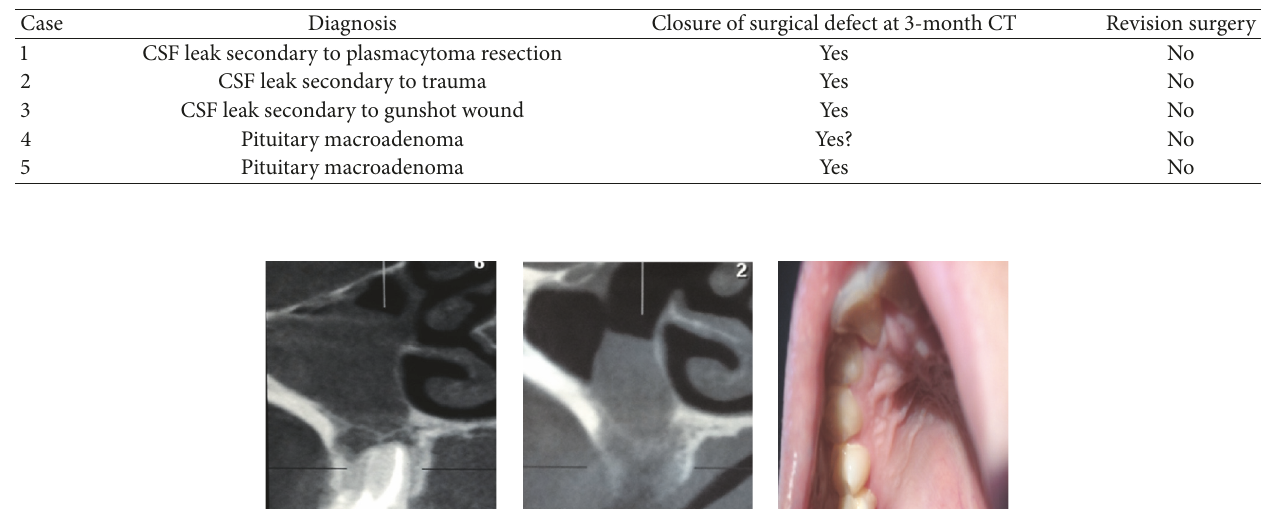
Table 1: Patients selected in this study. CT: computed tomography; CSF: cerebrospinal fluid.